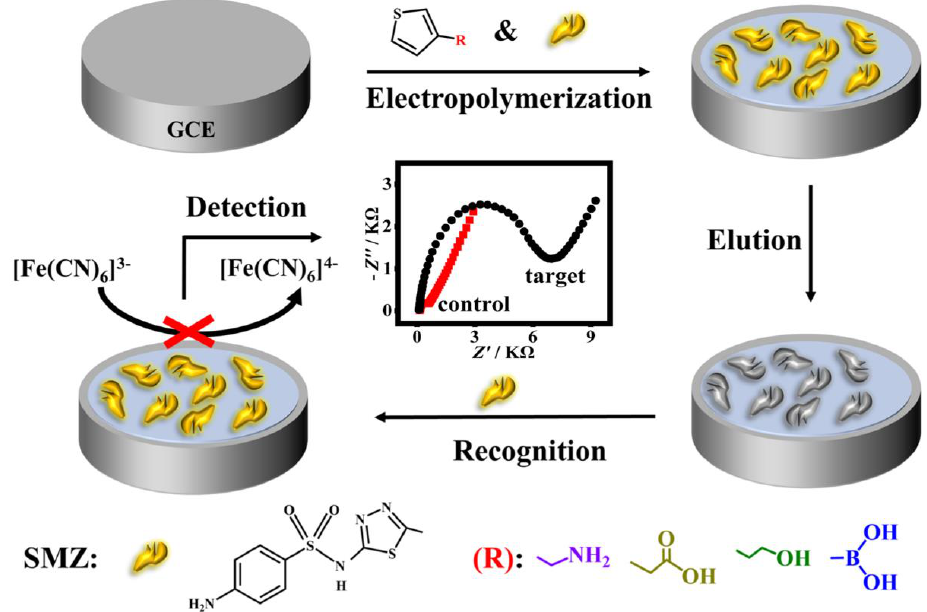
Scheme 1. Schematic diagram of the preparation of a MIP-based impedance sensor for sulfamethizole (SMZ) detection.